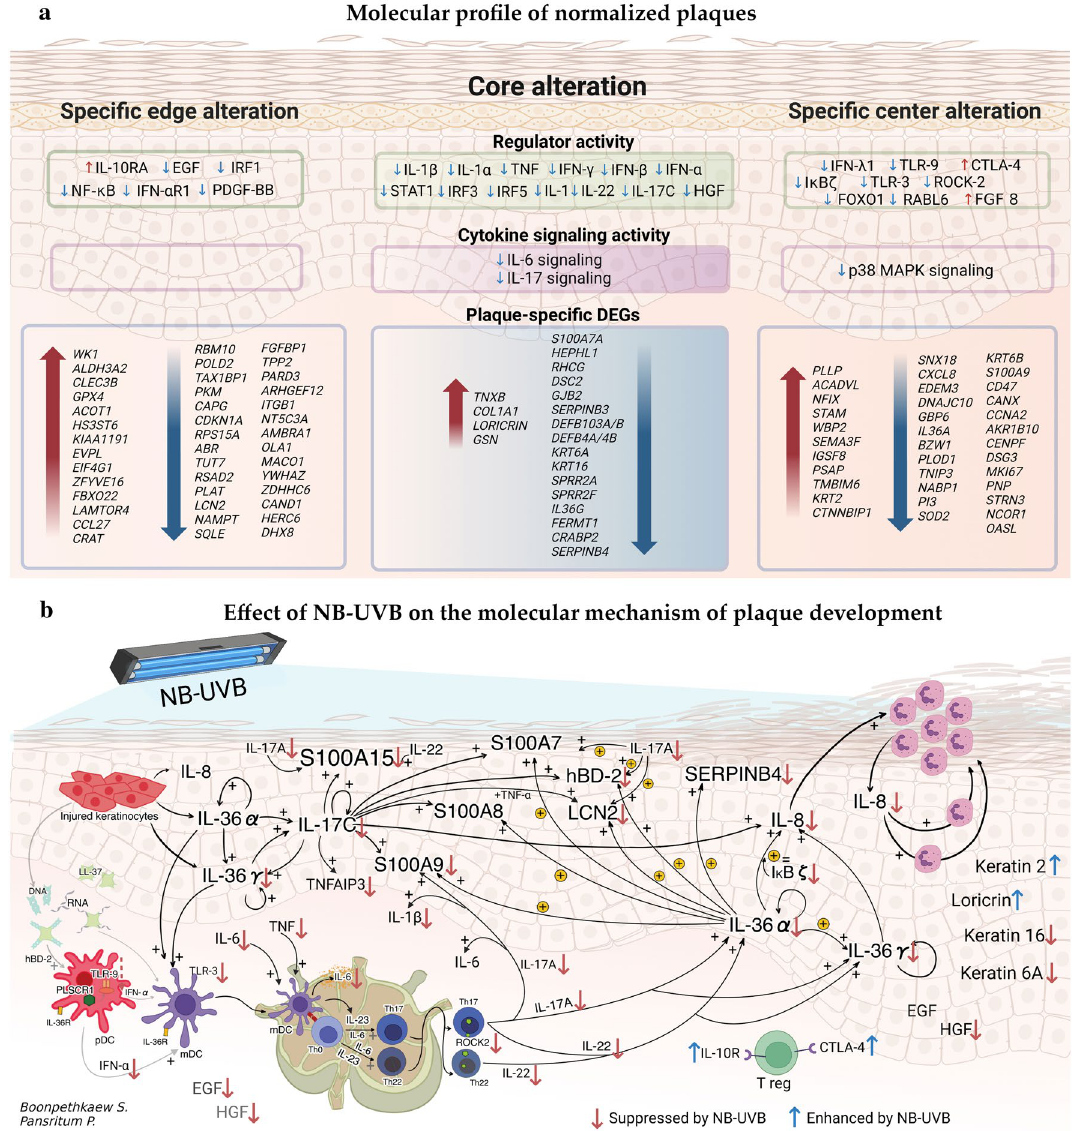
Figure 6. Molecular profile of normalized plaques and potential NB-UVB mechanism. ( a ) Molecular profile of normalized plaques based on RNA-seq analysis. ( b ) NB-UVB treatment suppressed the initial molecules, and molecules along the following cascade, resulting in the suppression of inflammation and abnormal proliferation. In addition, NB-UVB enhanced the normal differentiation/proliferation of keratinocytes and enhanced immunosuppressive function. Figure 6b was created by Adobe photoshop and BioRender.com. CE skin Center of lesional skin, NB‑UVB Narrow band ultra violet B, PE skin Peripheral edge of lesional